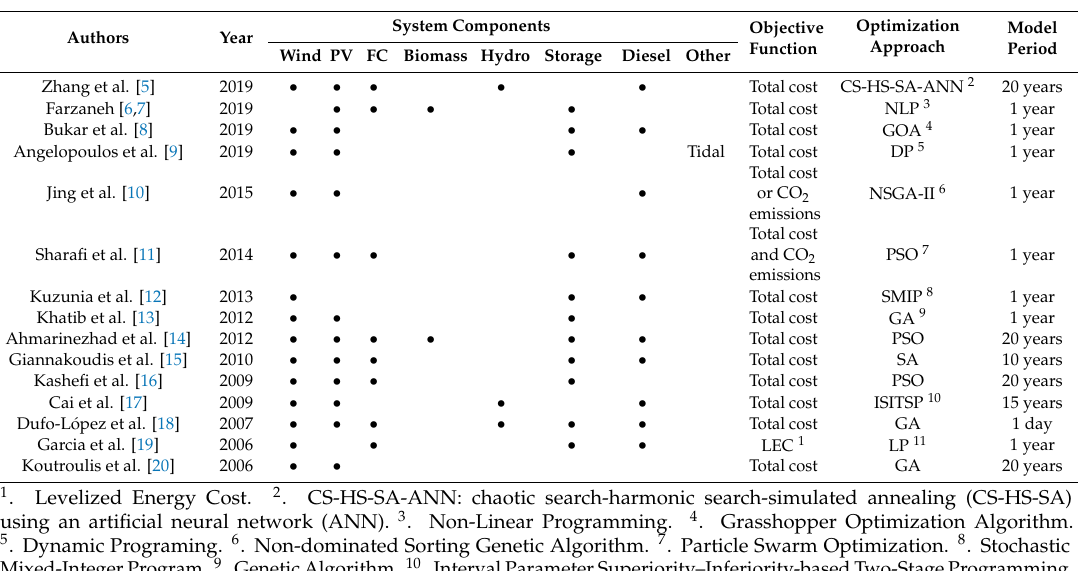
Table 1. Optimization methods used in microgrid modeling.